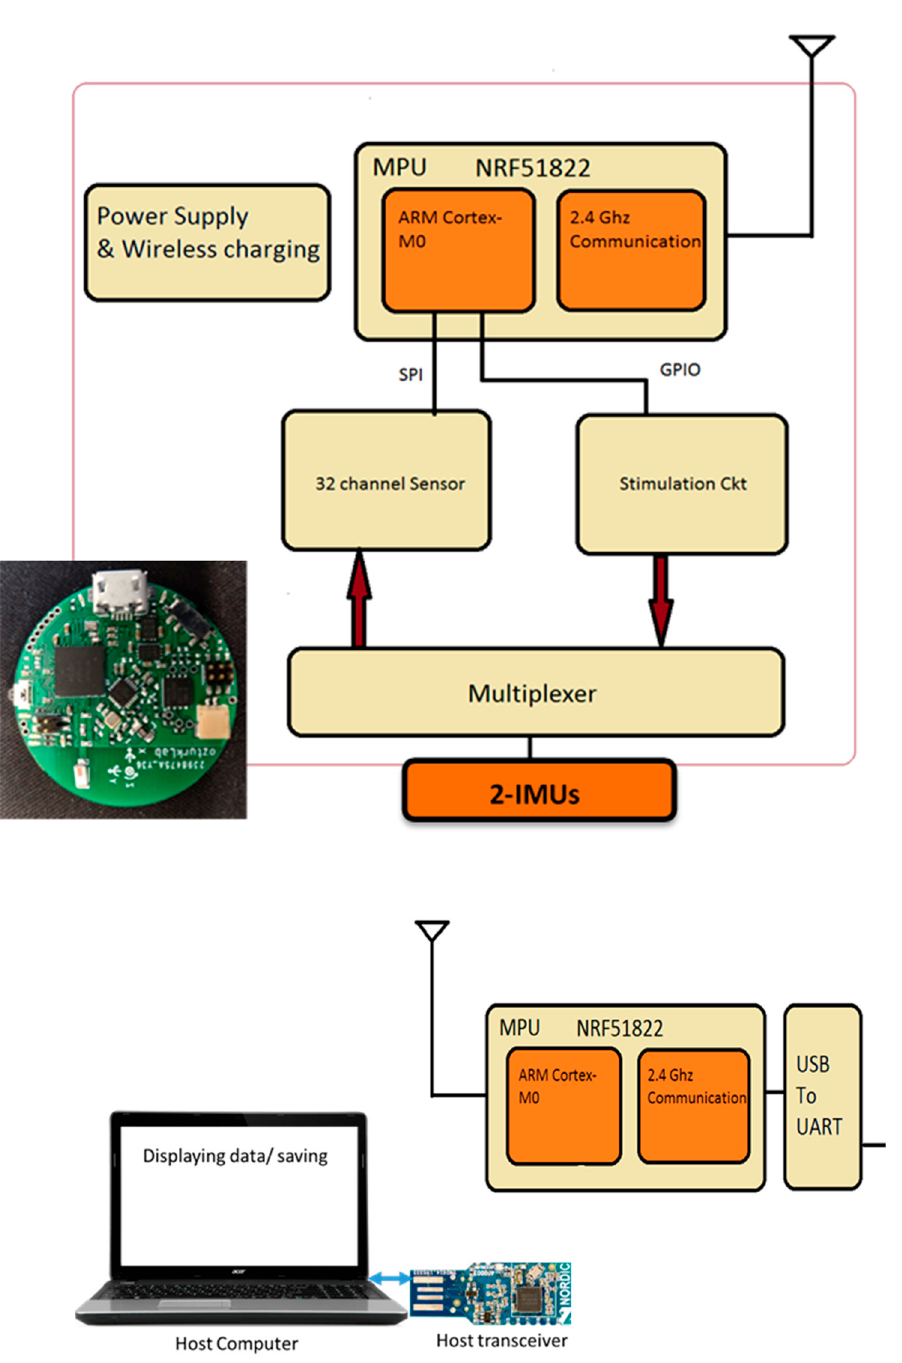
Figure 1. A custom designed IMU network to record leg movements: the sensor system diagram and the manufactured wireless IMU sensor circuit.